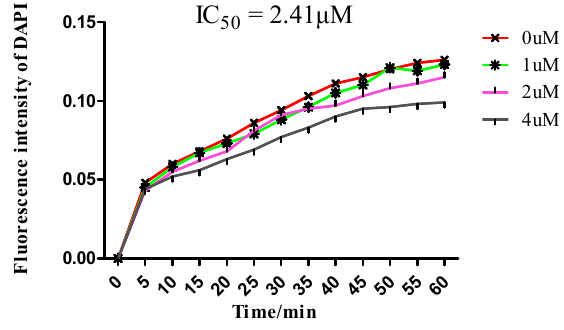
Figure 7. Tubulin polymerization inhibitory activity of compound 11f .